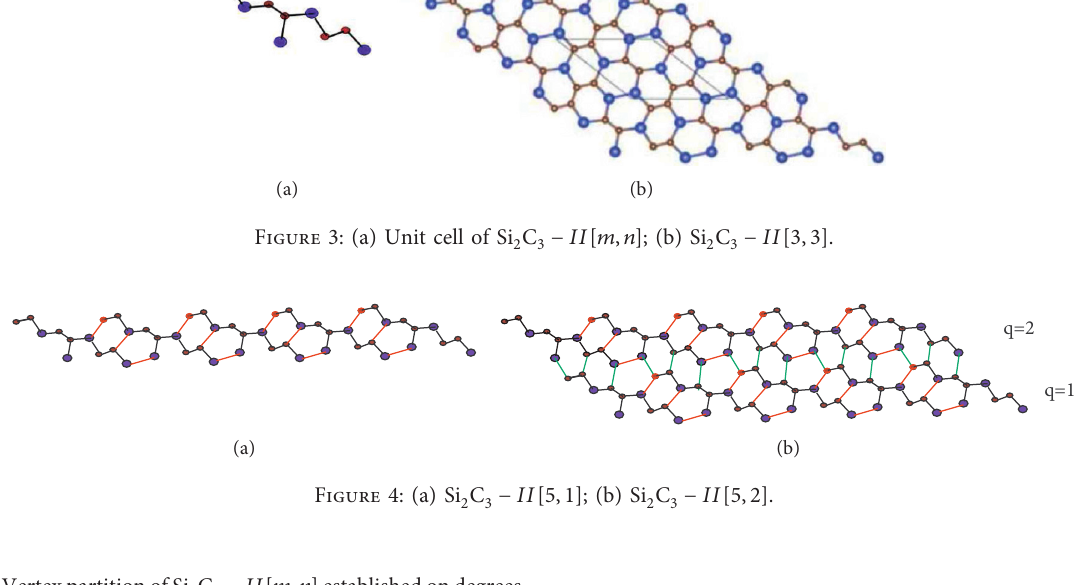
− II [ m,n ] , m,n, s ≥ C 2 3